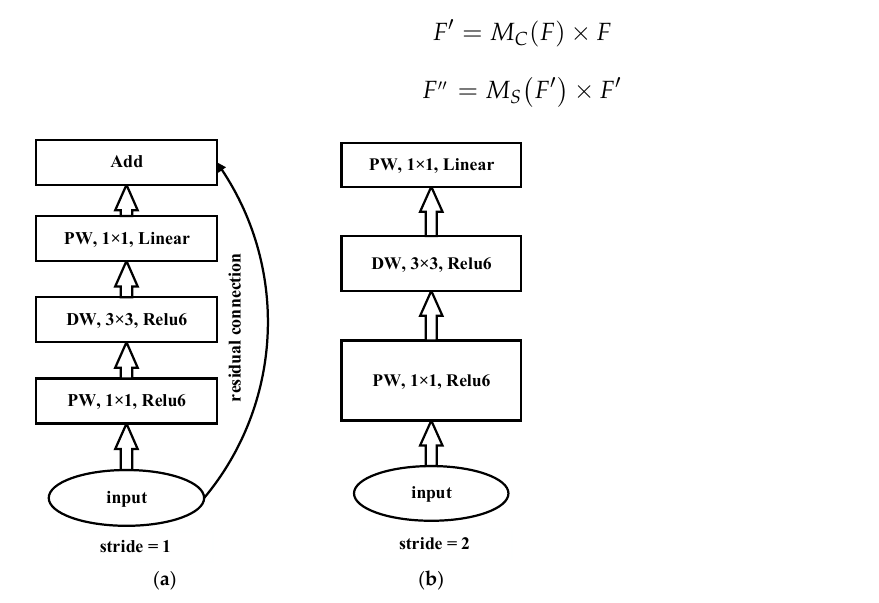
Figure 3. MoboileNetV2 linear bottleneck with inverted residual block structure. ( a ) Module with stride 1; ( b ) Module with stride 2.